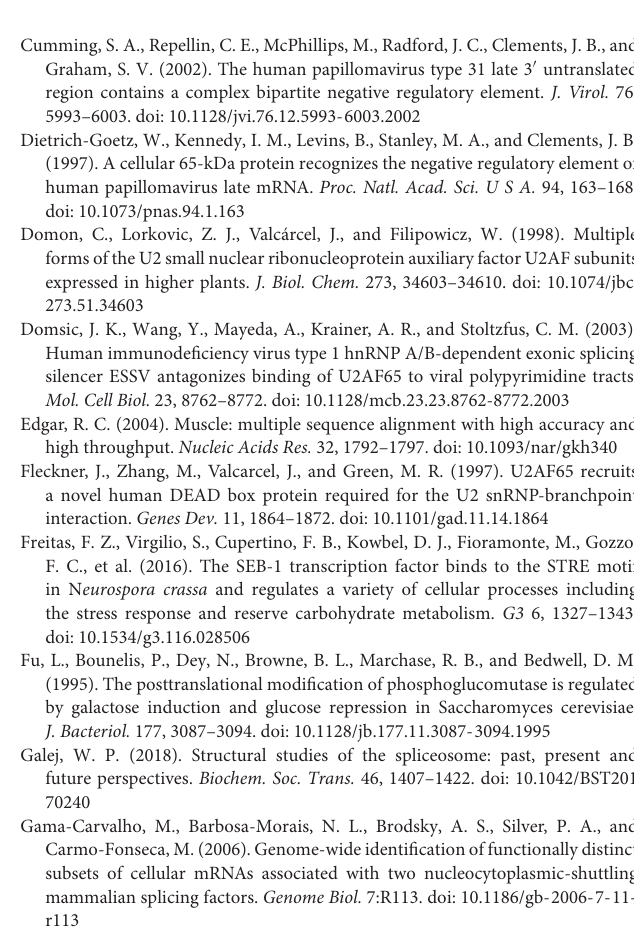
Supplementary Figure 1 | Motifs of the genomic structure. Consensus sequence of the top 10 identified DNA motifs are listed in the ascending order. Supplementary Figure 2 | Prediction of phosphorylation sites in different plants. Values exceeding the threshold indicate the possible involvement in phosphorylation; the higher the value, the greater the probability of involvement in protein phosphorylation. Supplementary Figure 3 | Prediction of the subcellular localization of U2AF65A gene expression in different plants. The Protein Subcellular Localization Prediction Tool (PSORT) was used to obtain the probability value of subcellular localization. TBtools was used to draw the heatmap. Supplementary Figure 4 | Classification and statistics of upstream cis -acting elements. The cis -acting elements retained after the final screening were divided into four categories according to their functions and are displayed in the bar chart. Supplementary Table 1 | Sequence summary of plant U2AF65A gene phylogenetic analysis. Supplementary Table 2 | Sequence summary of plant U2AF65A protein-protein interaction